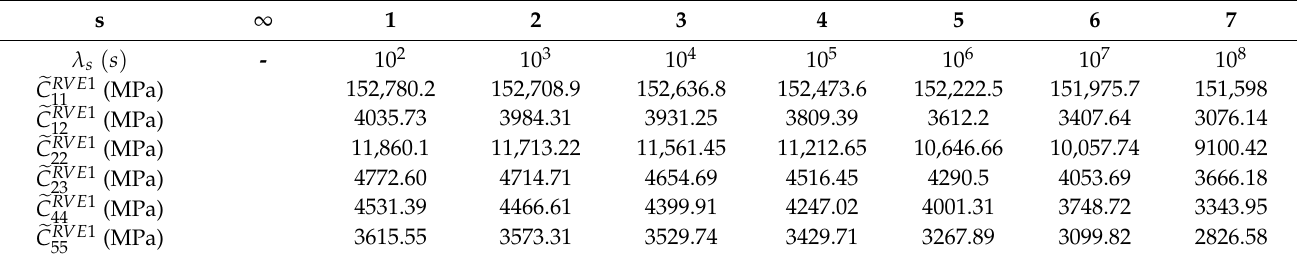
Table A2. The effective viscoelasticity of H-RVE1 at